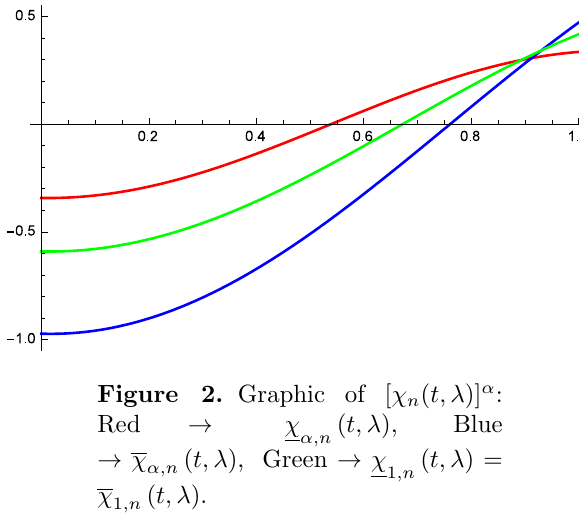
( t, λ ), Blue α,n ( t, λ ) = 1 ,n